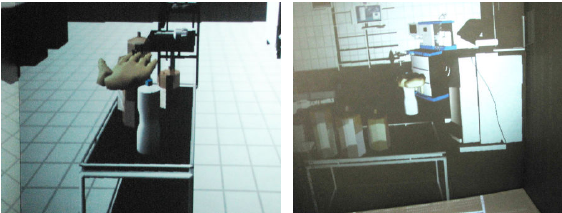
Figure 7. Hand approaching virtual object (left) and grasping it (right).